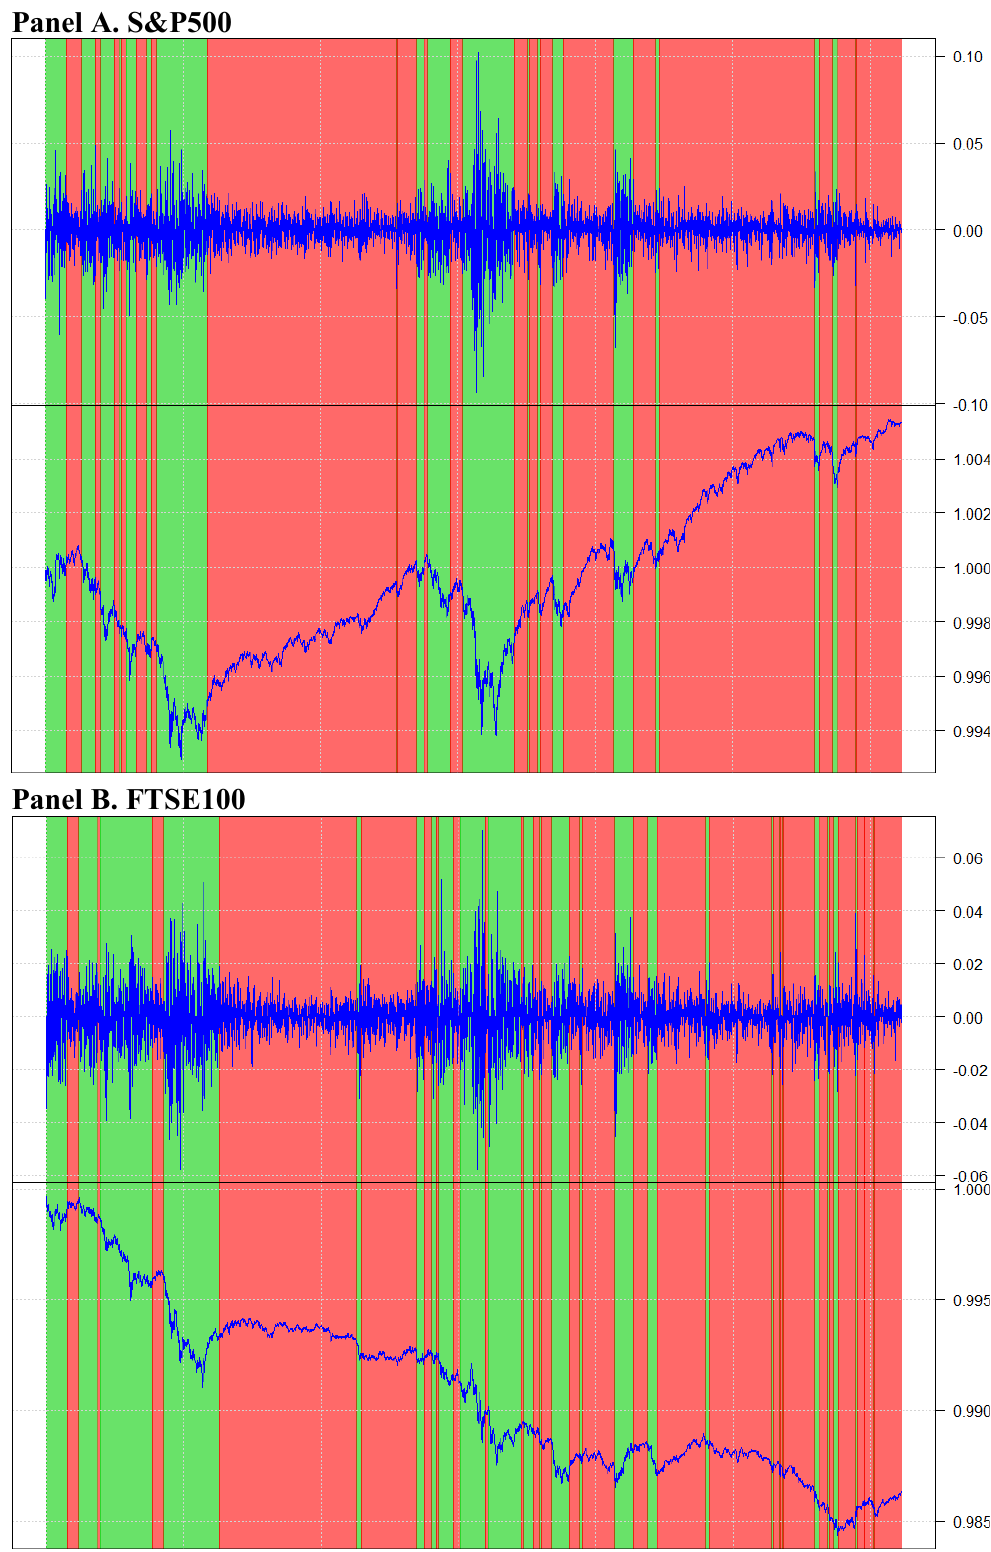
Figure 4. Volatility regimes. Note: This set figures depicts the volatility regimes in returns and equity prices of S&P500 and FTSE100 indices; the green color refers to high volatility regimes while the red color refers to low volatility regimes. Panel A refers to S&P500 index sample. Panel B refers to FTSE100 index sample.